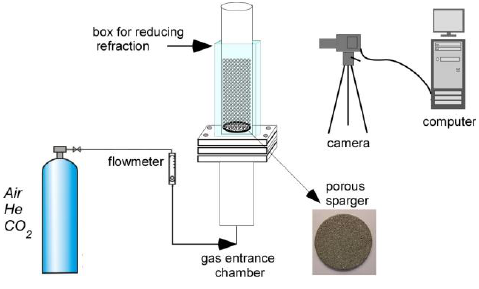
Figure 2. Experimental set-up.